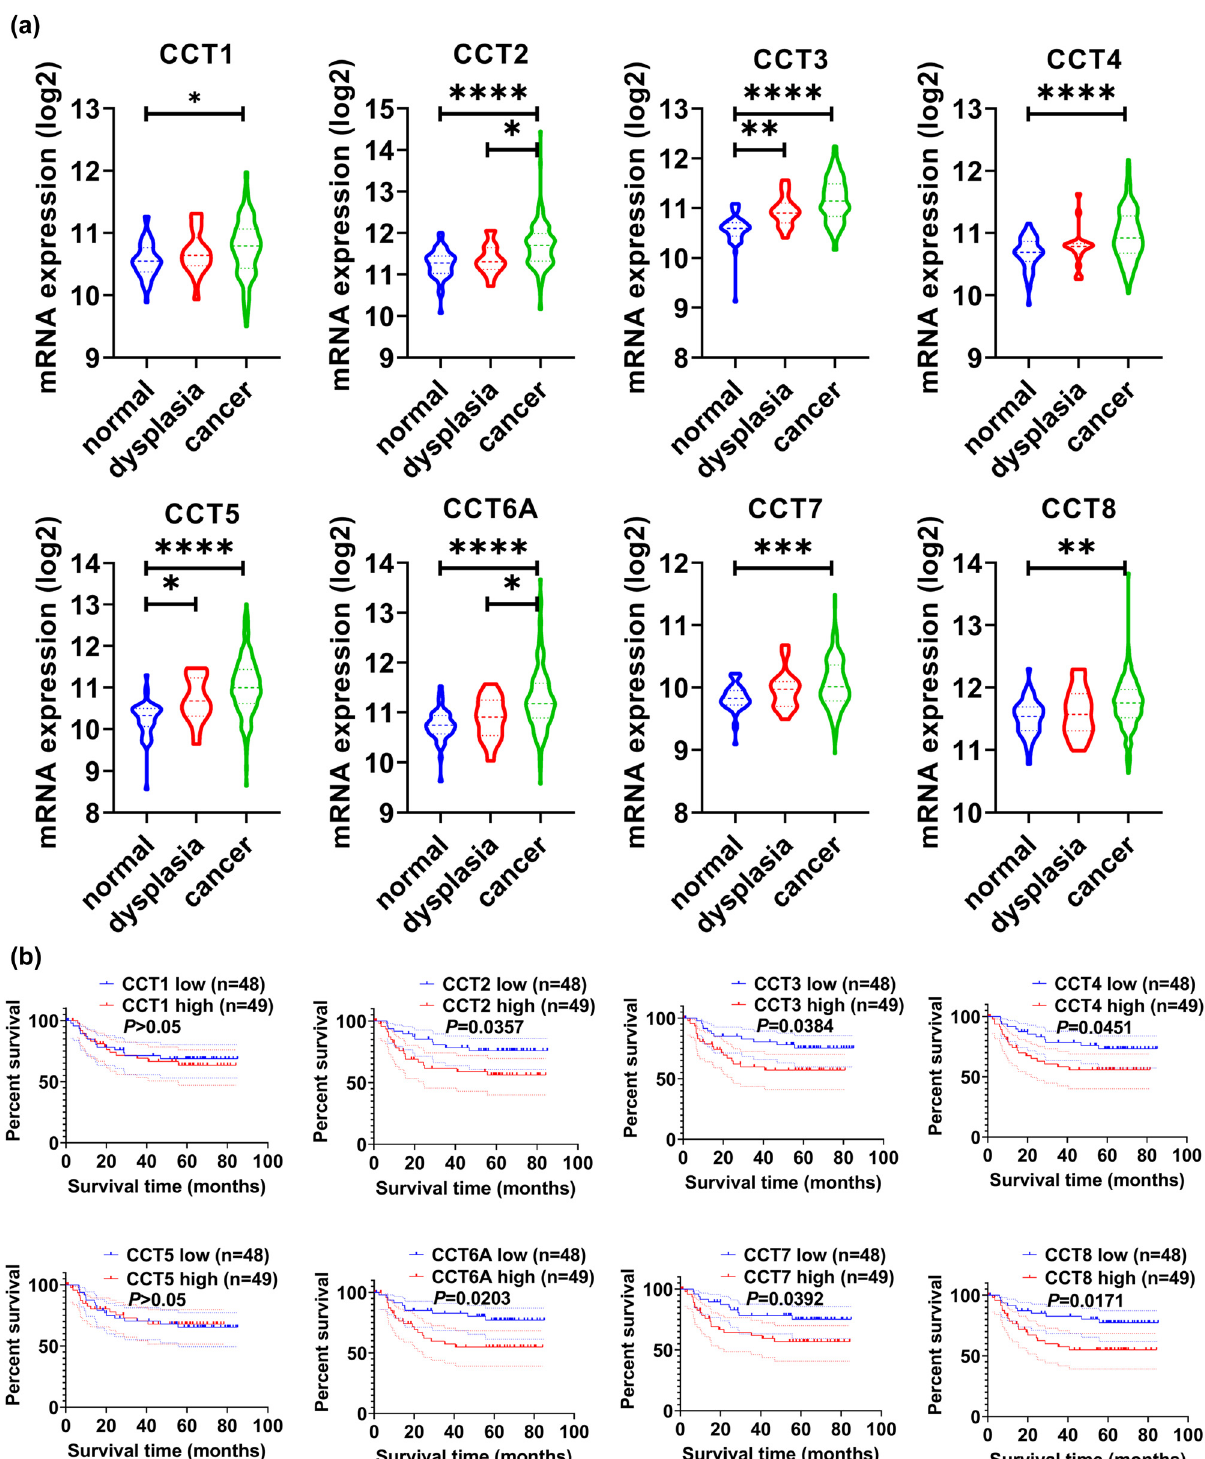
Figure 5: Validation of CCTs ’ di ff erential expression and prognostic values using GEO datasets. ( a ) Validation of CCTs expression level in GSE30784. The expression status of eight CCTs was positively correlated with the disease status. * P < 0.05; ** P < 0.01; *** P < 0.001; **** P < 0.0001. ( b ) Validation of CCTs ’ prognostic value in GSE41613. High CCTs expression groups had signi fi cantly lower OS than low CCTs expression groups. Shown is the log - rank P